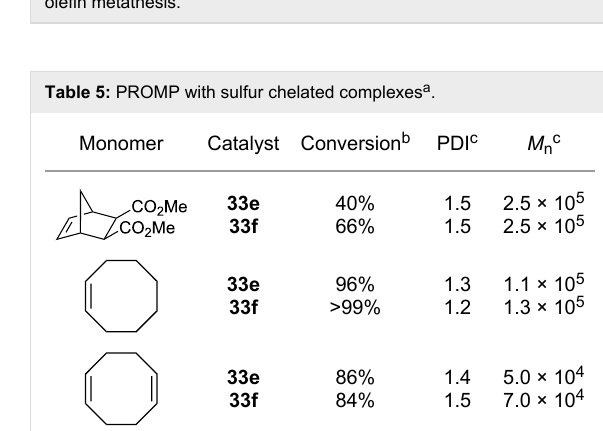
Figure 12: Sulfur chelated ruthenium benzylidene pre-catalysts for olefin metathesis.